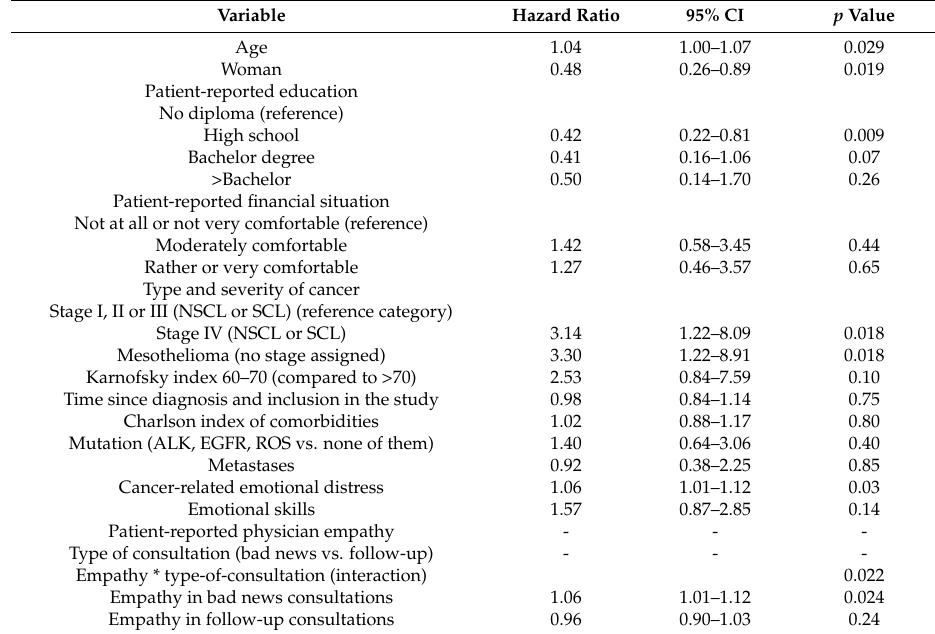
Table 3. Adjusted Cox Proportional Hazard Model for overall survival.